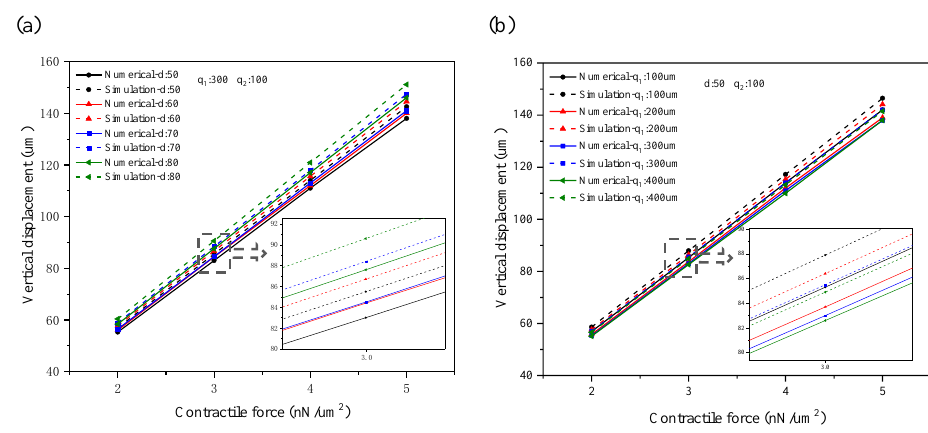
Figure 6. The effect of aperture and spacing on the bending displacement of a perforated microcantilever ( L * b * t f is 3000 μm * 1000 μm * 100 μm): ( a ) the effect of aperture on the bending displacement ( q 1 is 300 μm; q 2 is 100 μm); ( b ) the effect of spacing on the bending displacement ( d is 50 μm; q 2 is 100 μm).